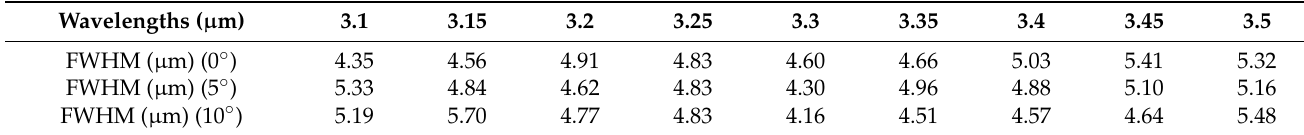
Table 6. The FWHMs of focal spots at wavelengths from 3.1 to 3.5 µ